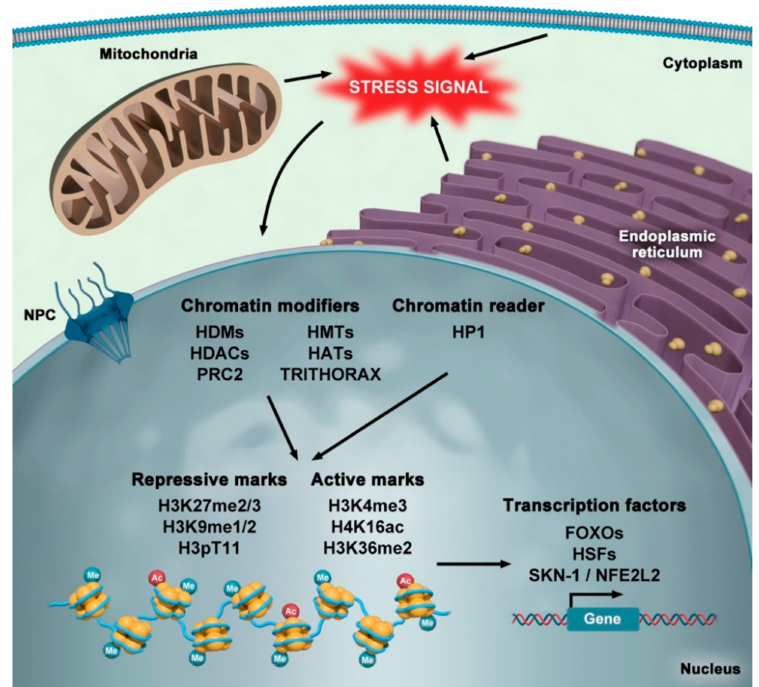
Figure 2. Epigenetic responses to stress. Stress signals from outside the cell or from specific organelles, such as mitochondria or the endoplasmic reticulum, are detected and processed by di ff erent signaling pathways [146]. The transduction of these stimuli results in the dynamic regulation of epigenetic mechanisms, mediated by a broad variety of chromatin protein modifiers acting as intermediates